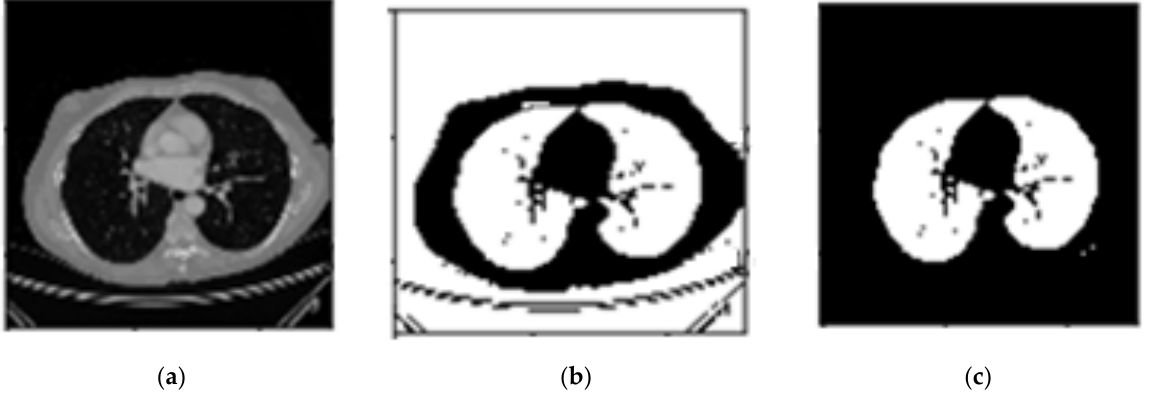
Figure 4. ( a ). Main CT image, ( b ). Binary image, ( c ). Image after eliminating border blobs.